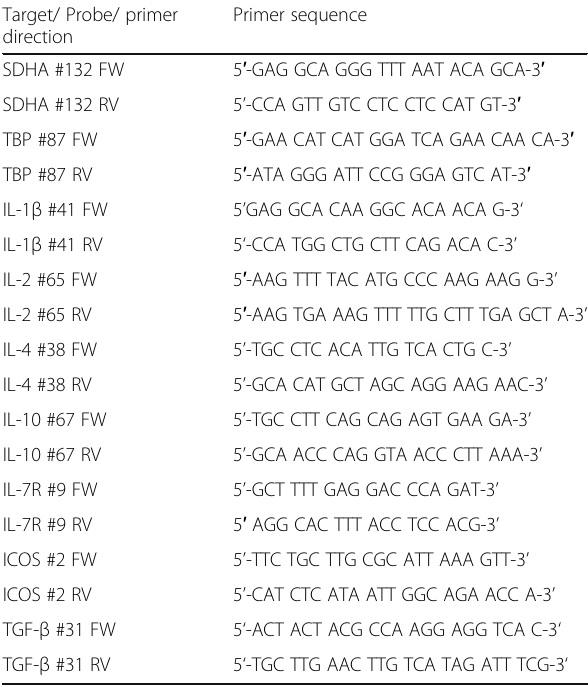
Table 7 qPCR primer and probes Target/ Probe/ primer